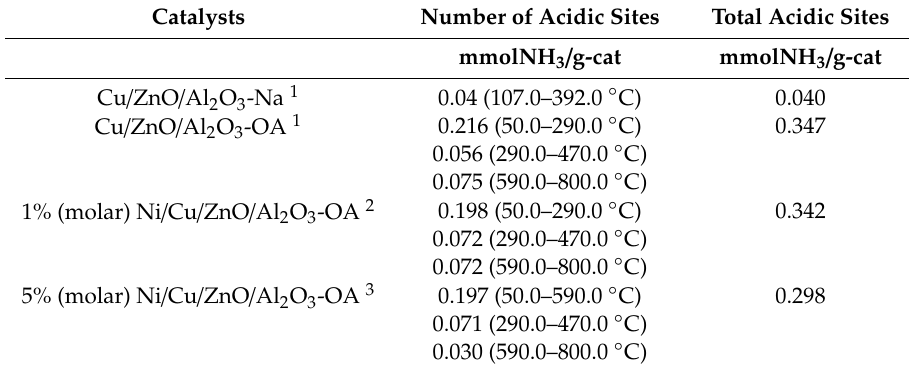
Table 1. Effect of Ni on the acidity of Cu/ZnO/Al 2 O 3 -OA catalysts. Catalysts Table 1. E ff ect of Ni on the acidity of Cu / ZnO / Al 2 O 3 -OA catalysts. Catalysts